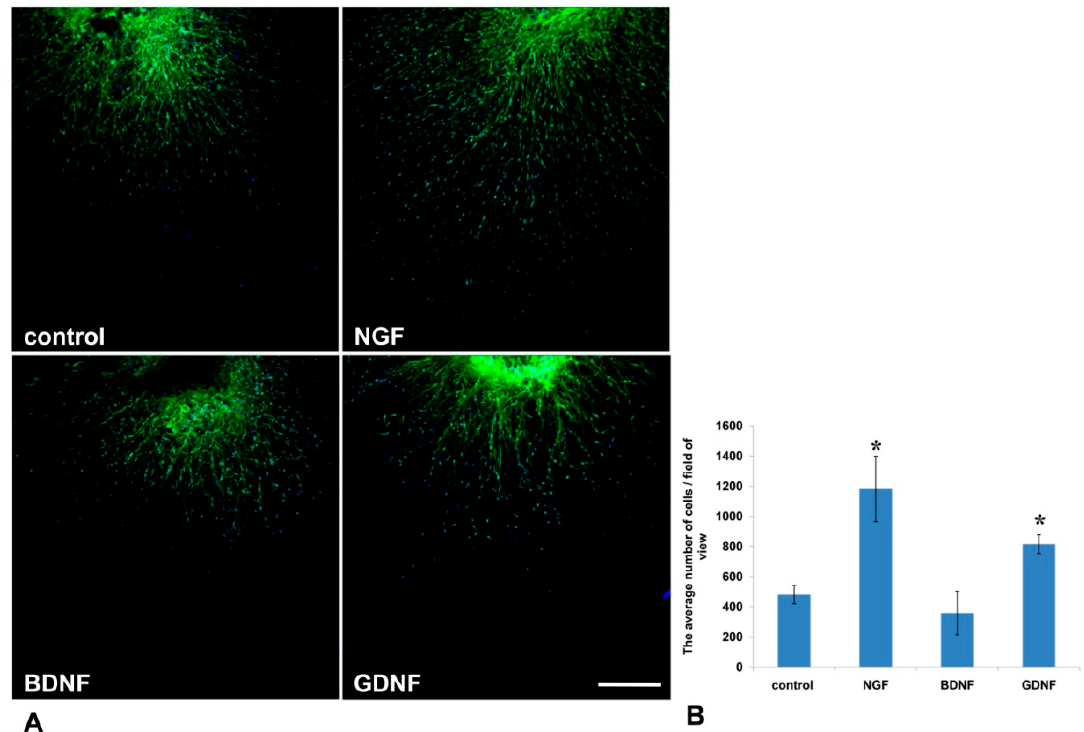
Figure 6. GDNF and NGF stimulated migration of Nestin-green fluorescent protein (GFP) cells from DRGs into the Matrigel in a 3D explant model. ( A ) A microphotograph presents the DRG from Nestin-GFP mouse in a drop of Matrigel. Nuclei are counterstained with DAPI, and green fluorescence corresponds with Nestin-GFP-expressing cells. Scale bar: 250 μ m. ( B ) A graph presenting the average number of double-positive (GFP and DAPI) cells that migrated into the Matrigel. Data are presented mean ± standard deviation (SD), p < 0.05, n = 4.